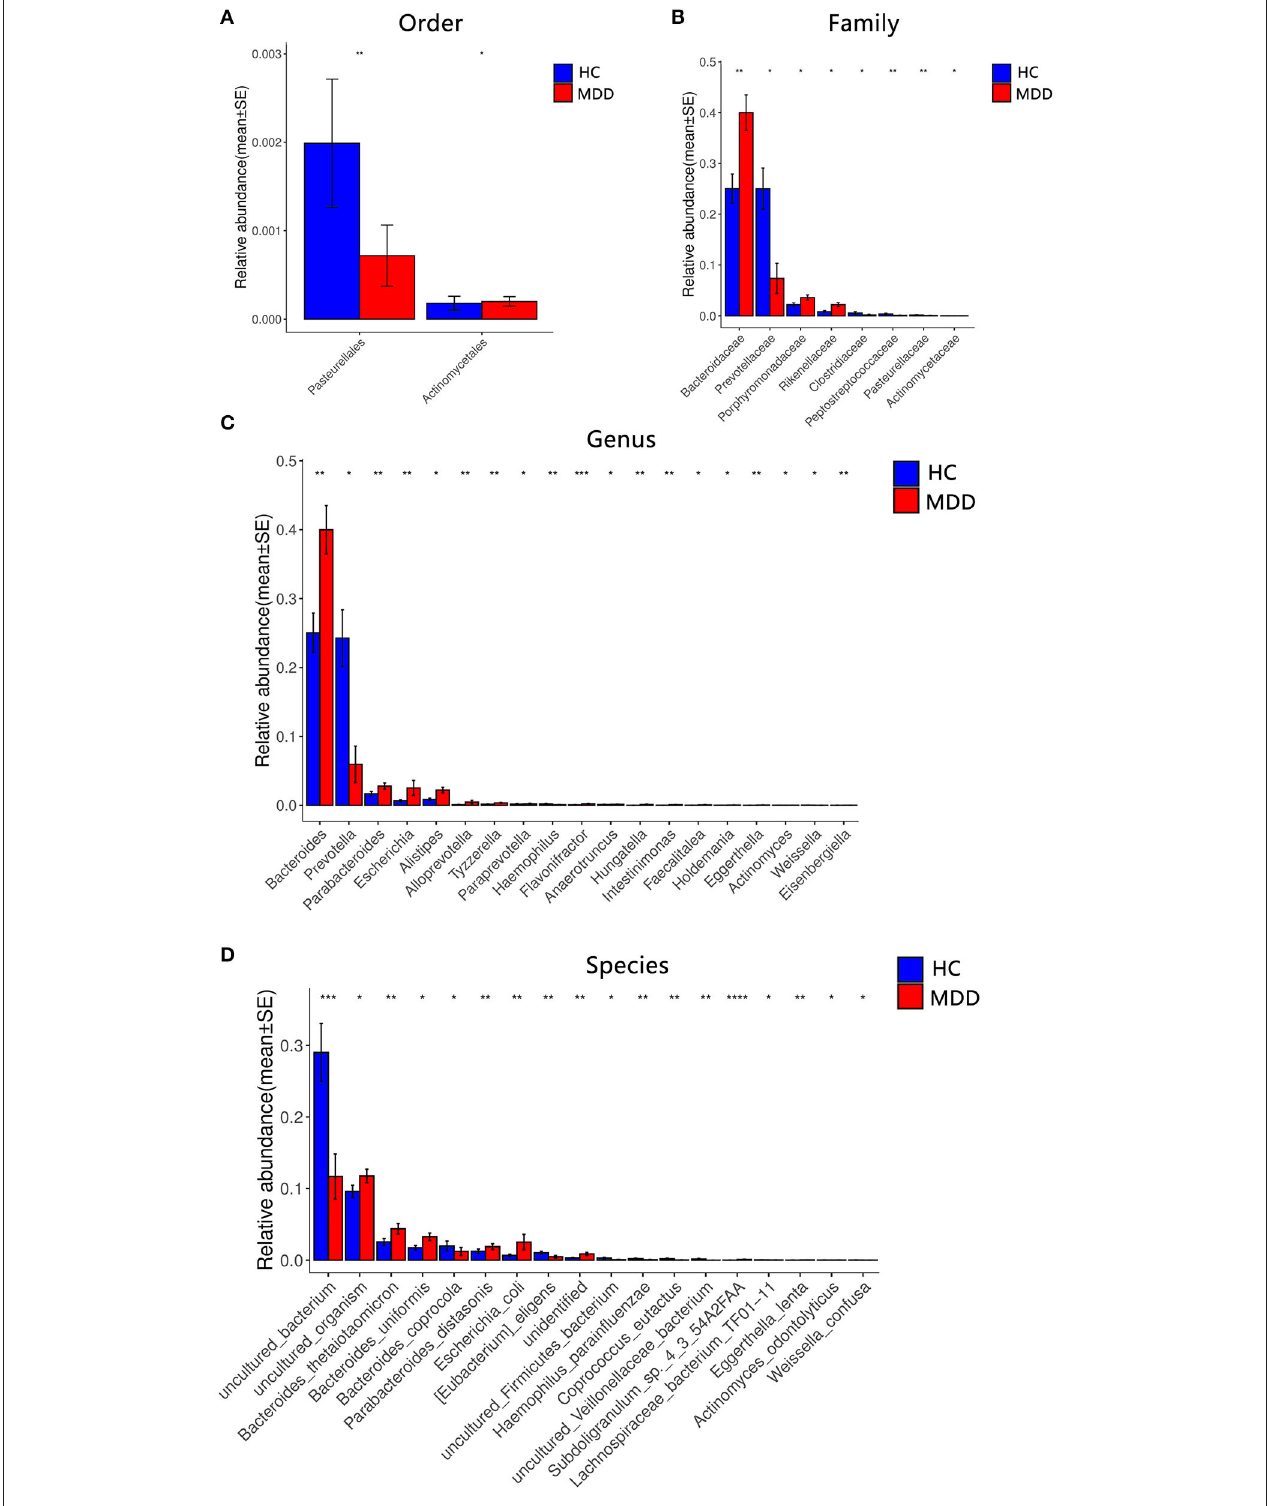
FIGURE 4 | Comparison of the microbial abundance among the MDD group and HC. Dominant bacteria with relative abundances > 0.01%. After exclusion, the Wilcoxon signed-rank test was applied to identify the differentially abundant orders (A) , families (B) , genera (C) , and species (D) . Among these, the highest means of the phylogenetic abundance in the enriched cohort were drawn as bar plots (* p < 0.05, ** p < 0.01, *** p < 0.001, **** p < 0.0001).